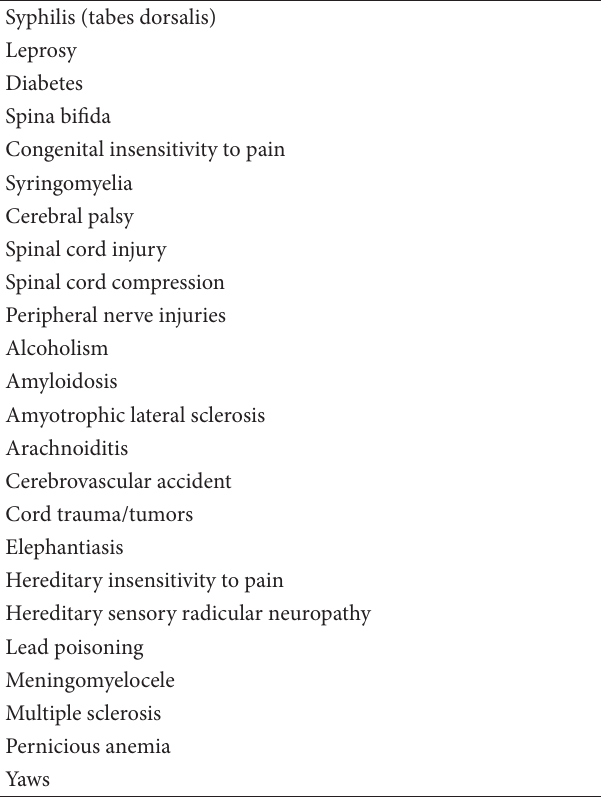
Table 1: Diseases associated with Charcot’s osteoarthropathy.